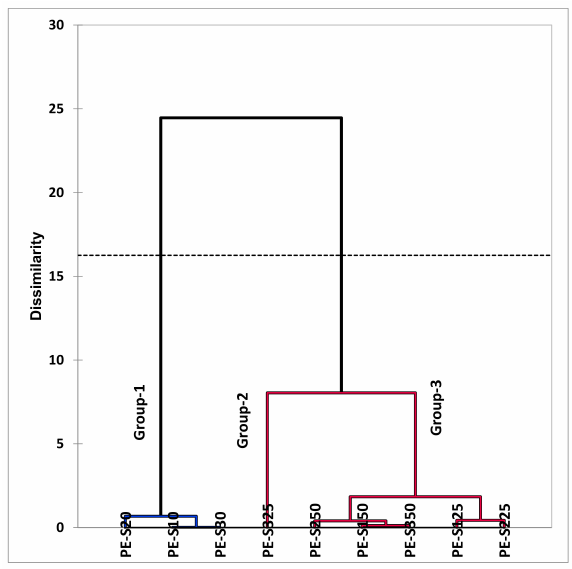
Figure 3. Dendrogram representing the arrangements of composites in groups.